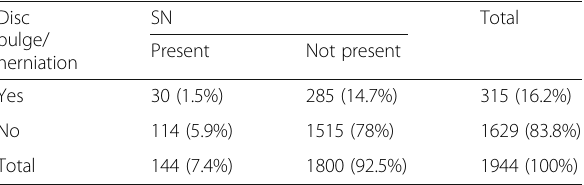
Table 5 Significant relation between the SN and disc bulge/ herniation Disc bulge/